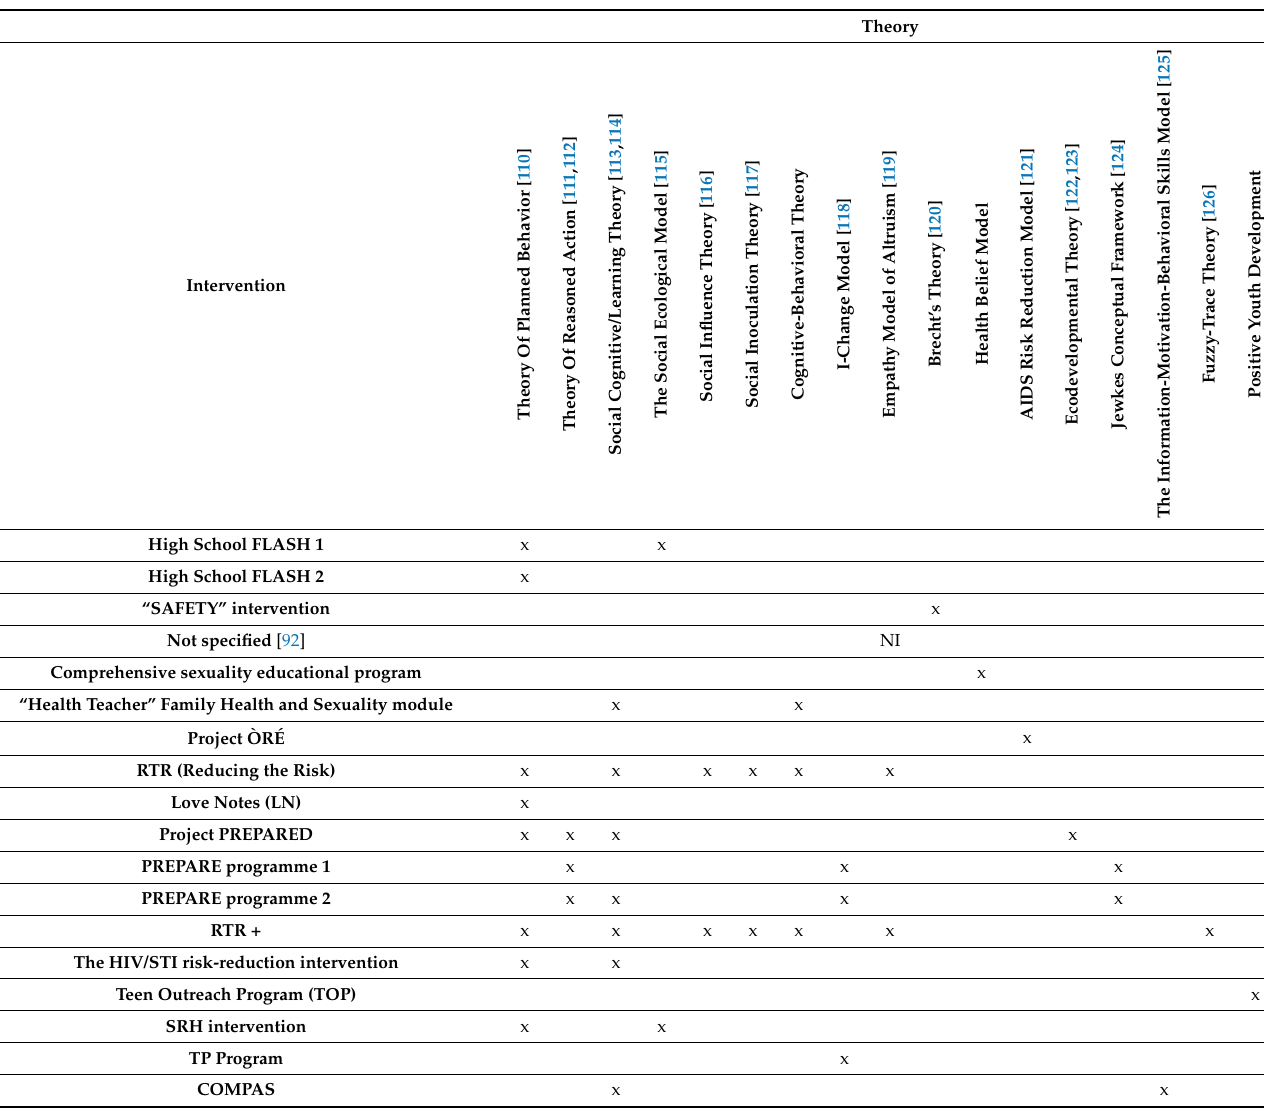
Table 4. Theoretical frameworks of sexuality education